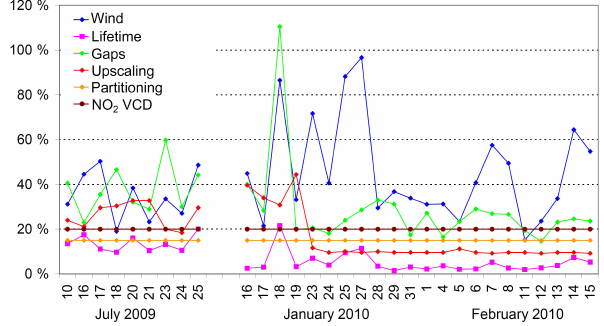
Figure 13. Individual errors derived for all car MAX-DOAS mea- surements considered in this study.